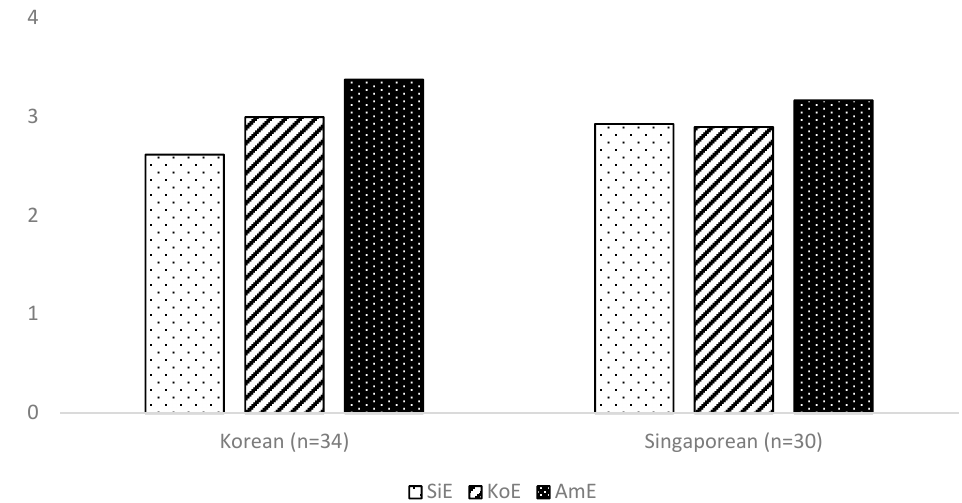
Figure 3. Mean score of ratings for SiE, KoE, and AmE speakers from two groups: 5-year-old Korean children ( right ) and Singaporean children ( left ).